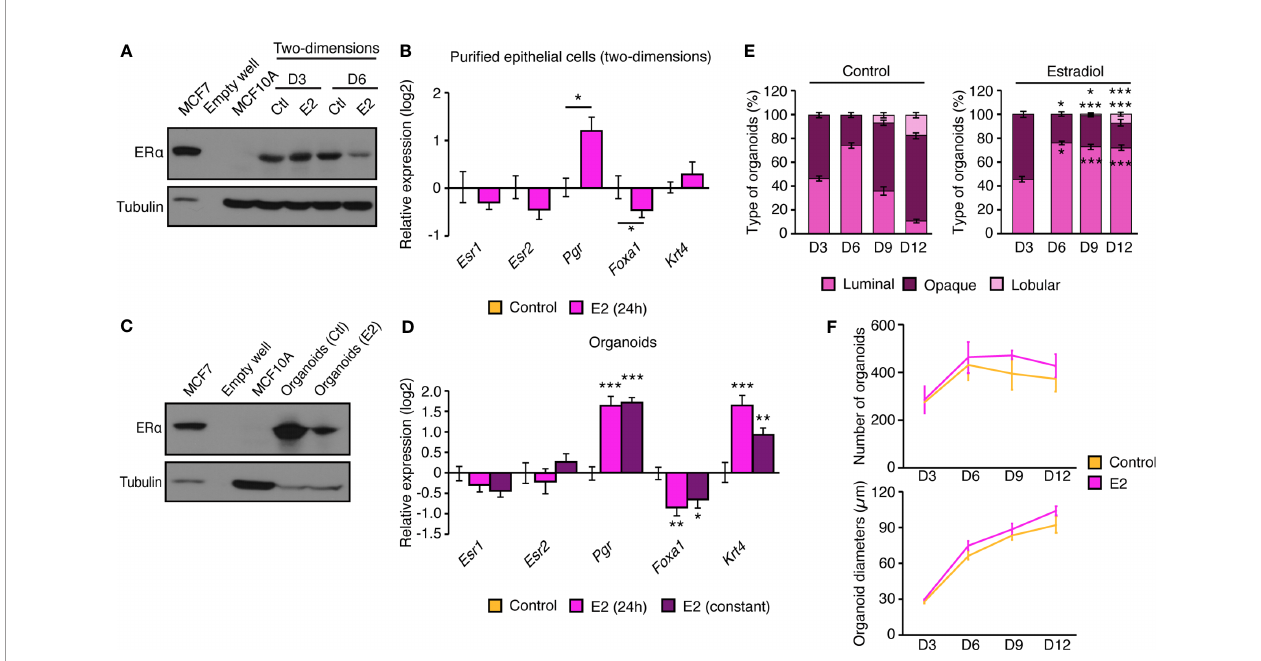
FIGURE 4 | Primary mammary epithelial cells in two- and three-dimensions express ER a . (A) Western blot analysis of ER a protein expression in mammary epithelial cells in two-dimensional culture after 3 and 6 days in culture with E 2 or vehicle. MCF7 human breast cancer cells and MCF10A human immortalized mammary epithelial cells were used as positive and negative controls for ER a protein expression, respectively. (B) qRT-PCR analysis of genes regulated by estrogens in two- dimensional culture following a 24 h treatment with E 2 or vehicle. (C) Western blot analysis of ER a protein expression in mammary organoids after 12 days in culture. MCF7 human breast cancer cells and MCF10A human immortalized mammary epithelial cells were used as positive and negative controls for ER a protein expression, respectively. (D) qRT-PCR analysis of genes regulated by estrogens in primary mammary gland organoids following 24 h or 10 d of treatment with E 2 or vehicle. For (B, D) , results are shown as mean ± SEM of three independent experiments performed at least in duplicate. (E) Percentage of luminal, opaque, and lobular organoids over time, maintained in culture with and without E 2 . Results are shown as the mean ± SEM of one out of three independent experiments. * p < 0.05; ** p < 0.01; *** p < 0.001. (F) Number of visible organoids treated with E 2 or vehicle. Results are shown as the mean ± SEM of two independent experiments performed in